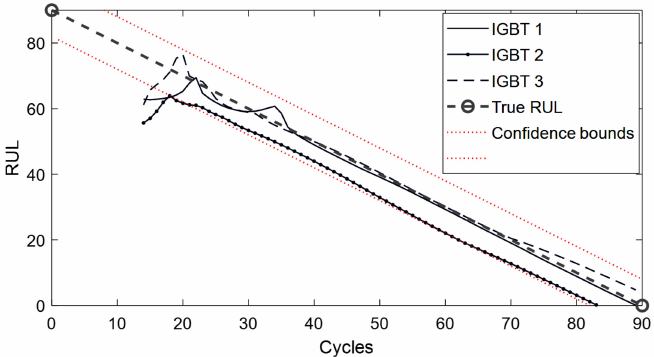
Figure 18. IGBT component predicted RUL. Reproduced from [17], IEEE.